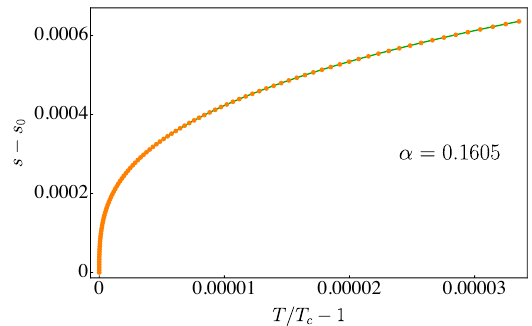
Figure 3 . Entropy density close to second order phase transition. Orange dots: numerical results. Green line: fit (4.5) with γ = 0 . 66 and s 1 = 0 . 02 .